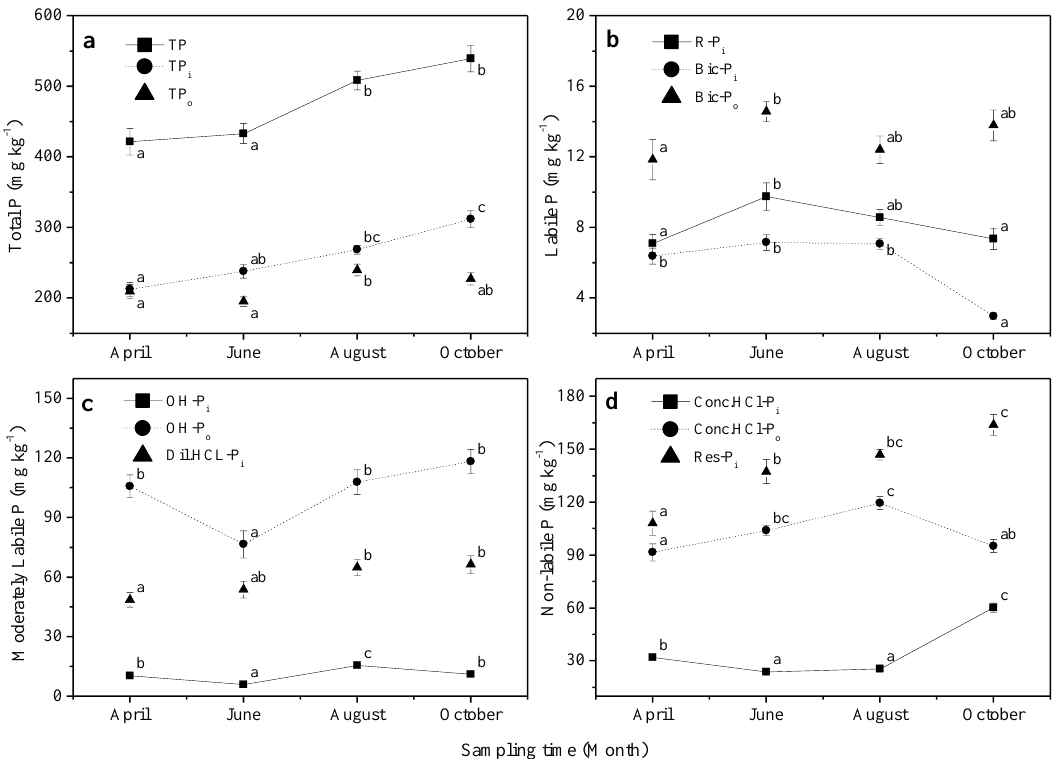
Figure 2. Seasonal changes in total ( a ), labile ( b ), moderately labile ( c ) and non-labile P ( d ) in L. principis-rupprechtii plantations. Each bar represents an average value across thinning treatments and soil depths ( n = 36), i.e., twelve plots × three soil depths. Error bars indicate standard error. Values within each sampling time followed by different letters differ significantly according to Tukey’s test ( p < 0.05).